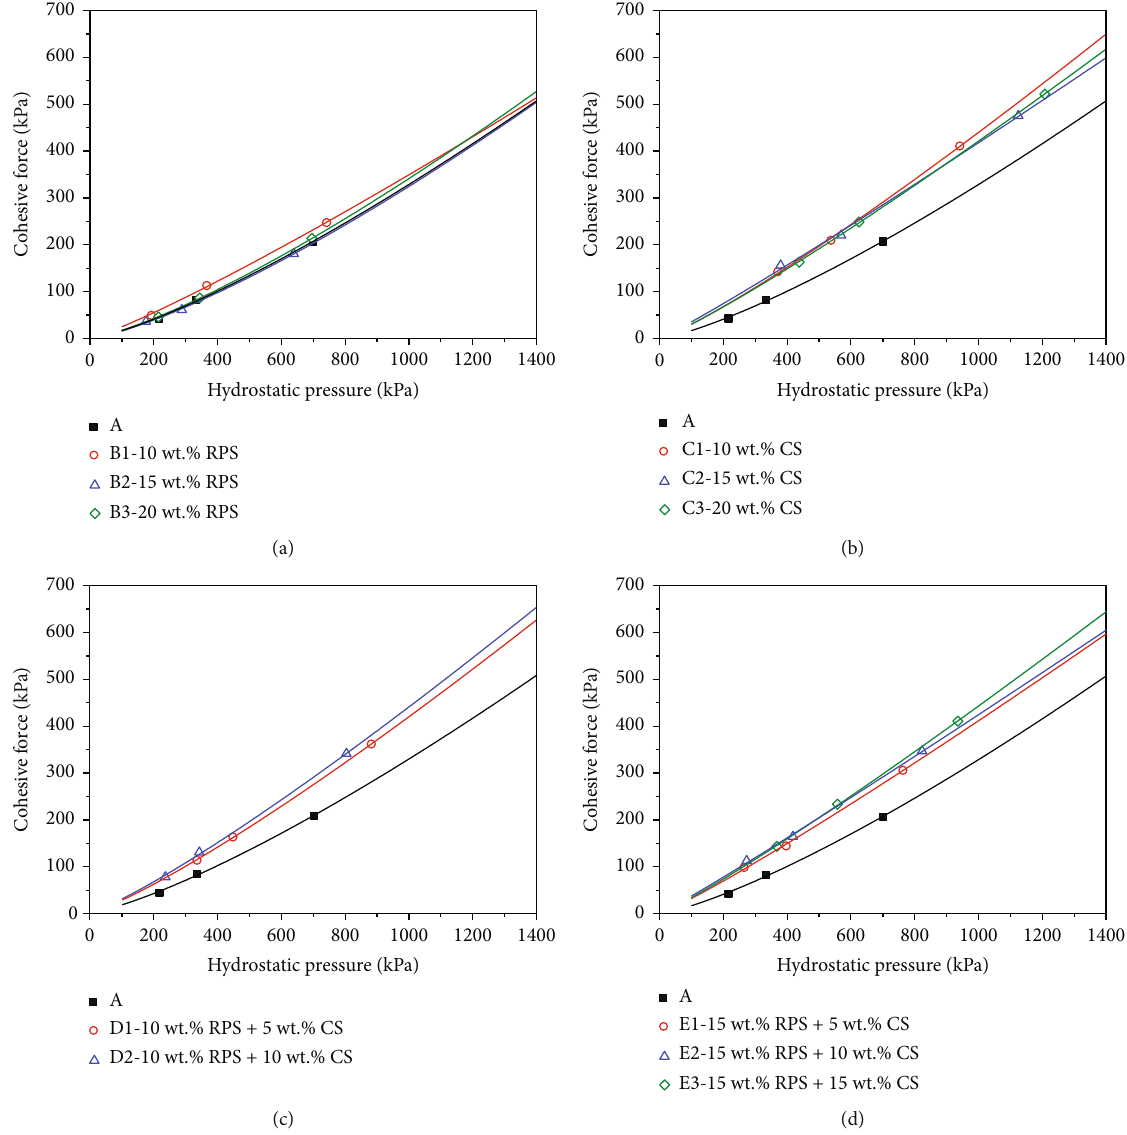
Figure 9: Relationships between the hydrostatic pressure and the cohesive force for the modi fi ed soils: (a) the red Pisha sandstone modi fi ed soils; (b) the carbide slag modi fi ed soils; and (c, d) the red Pisha sandstone and carbide slag modi fi ed soils.